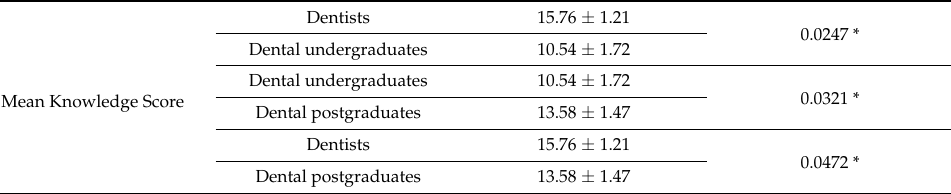
Table 3. Intergroup comparison of knowledge score between dentists, dental undergraduates, and postgraduates.